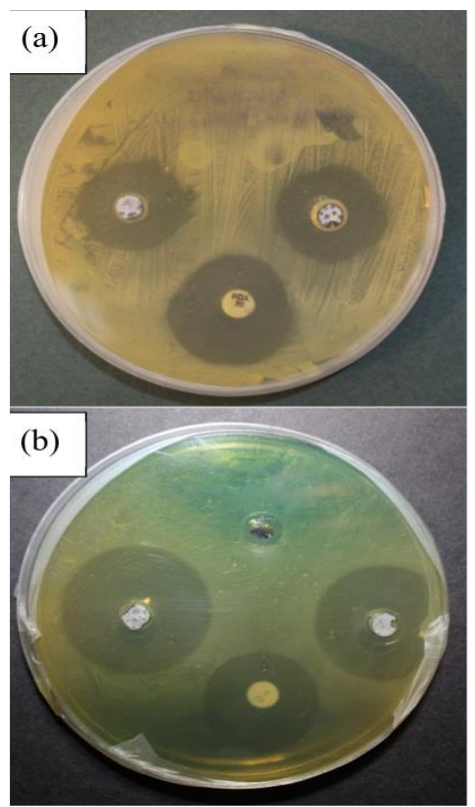
Fig. 7. Inhibitory effect of Erythromycin loaded GNP samples against Staphylococcus aureus (a); and Pseudomonas aeruginosa